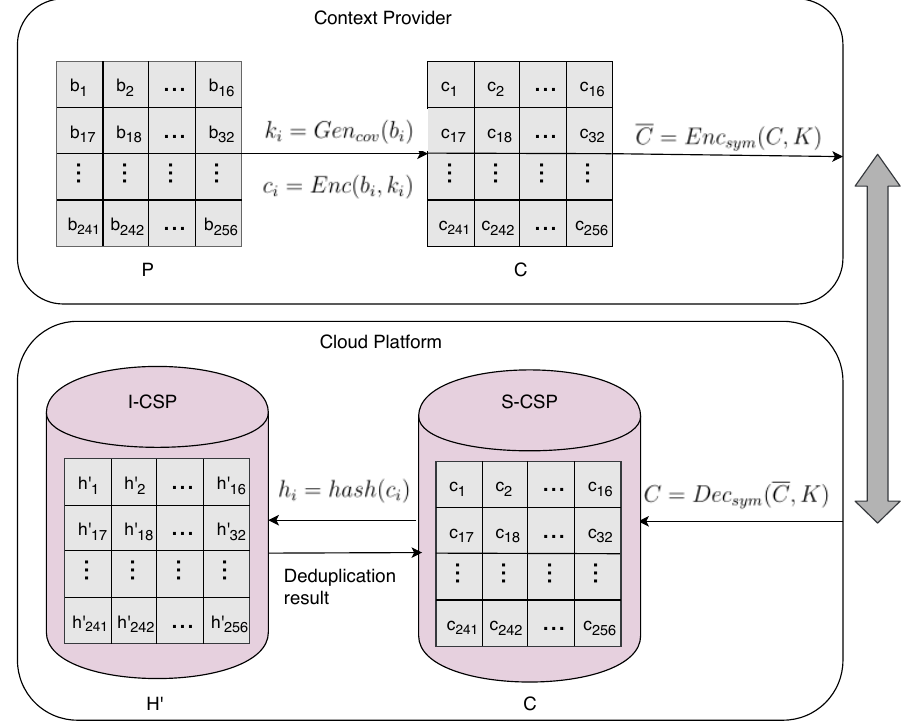
Figure 2. The block-level deduplication system based on the convergent encryption